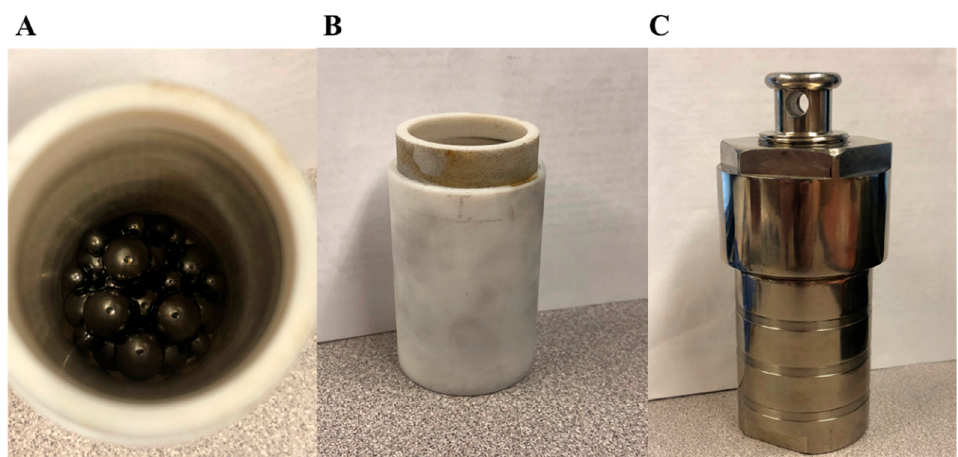
Figure 2. Graphene wet-ball milling container setup. ( A ) Twenty steel balls with a diameter of 8.7 mm (11/32”) and 10 steel balls with a diameter of 4.5 mm (3/16”) were added. ( B , C ) Container assembly for shaker mill.